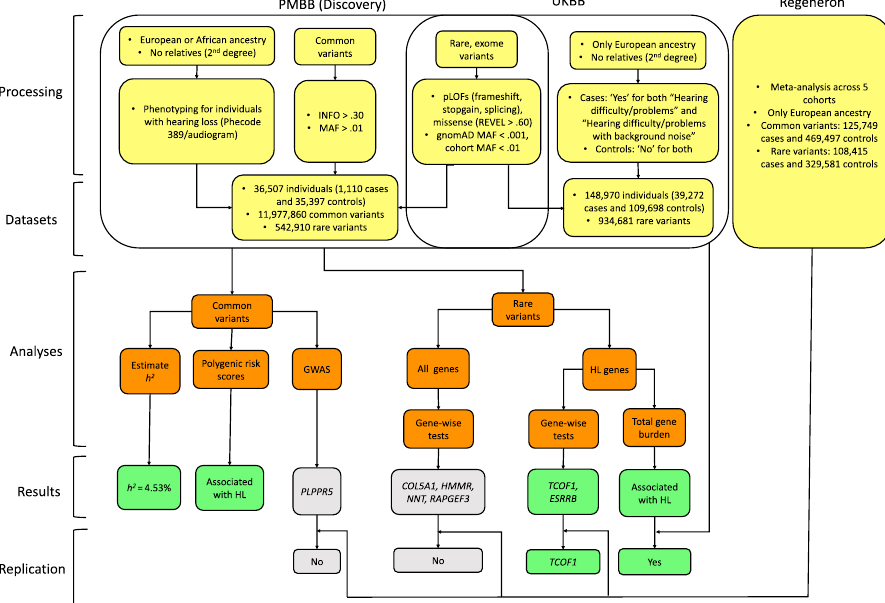
Fig 1. Project workflow, describing data pre-processing such as inclusion/exclusion criteria for individuals and variants, and final datasets used for analyses. Discovery analyses were performed in PMBB for both common and rare variants. Select results were replicated in UK BioBank and using the results of Praveen et al